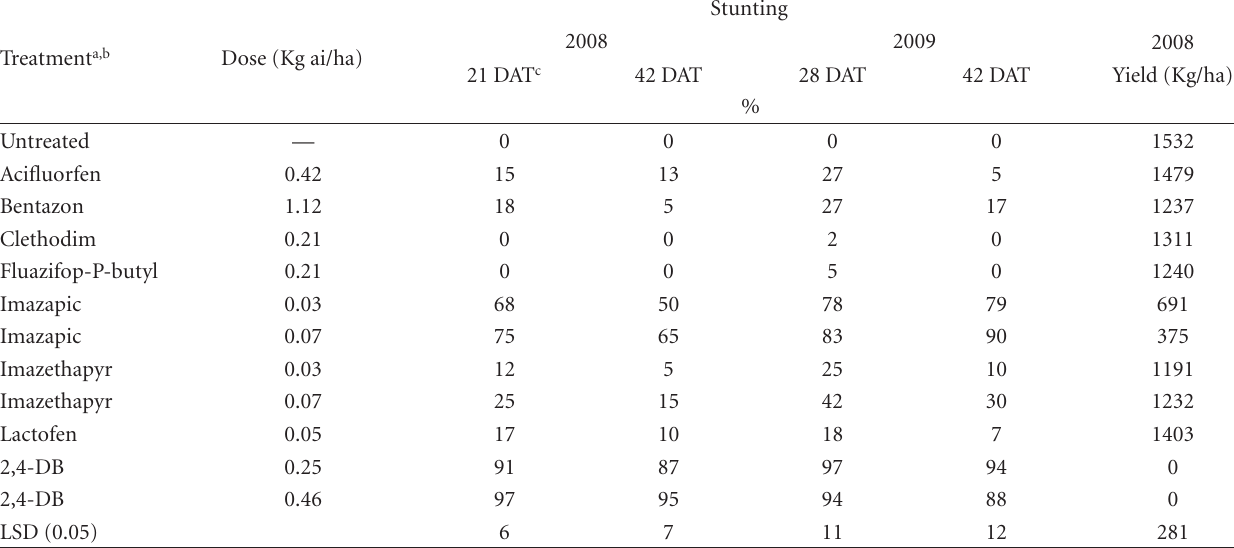
Table 2: Castor response to postemergence herbicides in the High Plains of Texas under weed-free conditions.